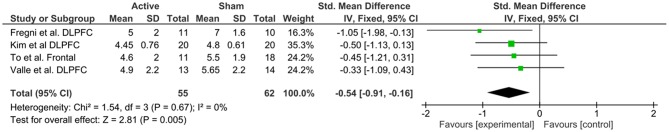
Forest plot of the effects of anodal DLPFC tDCS on pain levels (n = 4).